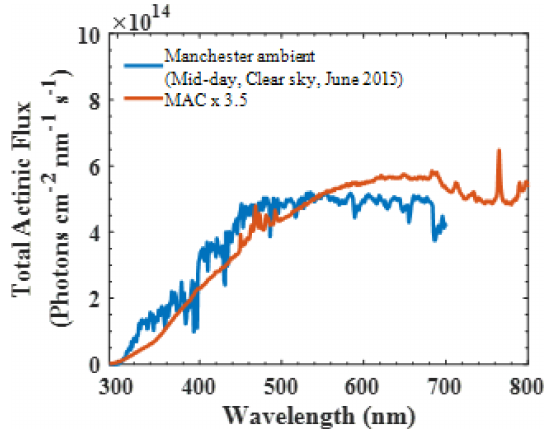
Figure 4. Total actinic flux spectrum in the MAC compared to the ambient light spectrum obtained in the city of Manchester (UK) midday with a clear sky in June